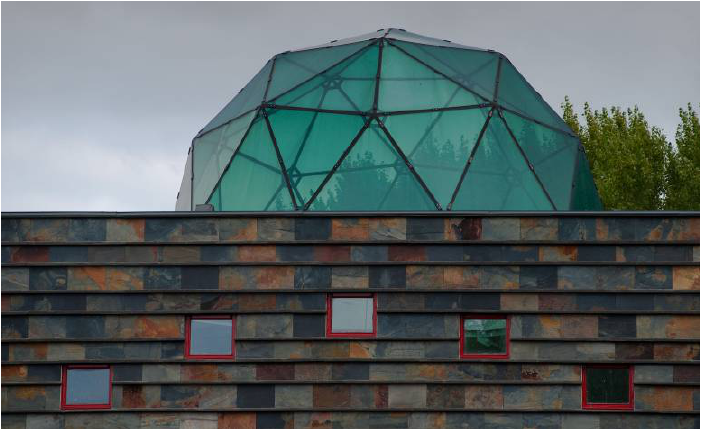
Figure 12: Close –up of dome (Photo Berend van der